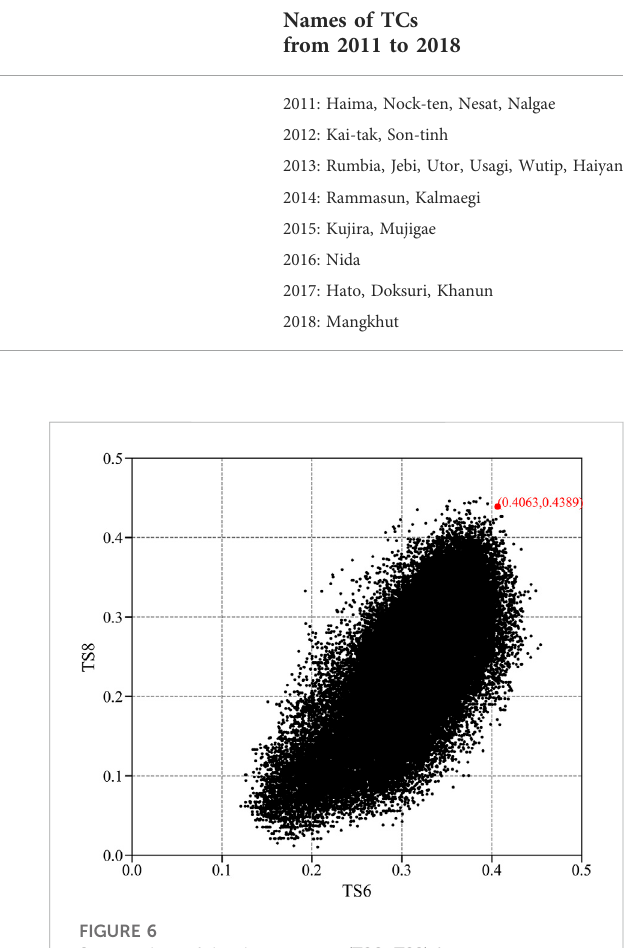
FIGURE 6 Scatter plots of the threat scores (TS6 – TS8) from 241,186 forecast schemes generated by the simulation experiment.TS6andTS8representthethreatscoresforpredicting the potential maximum gale of ≥ Beaufort Scale 6 and ≥ Beaufort Scale 8, respectively. The red scatter point indicates the best forecast scheme with maximal TSsum (TS6 +